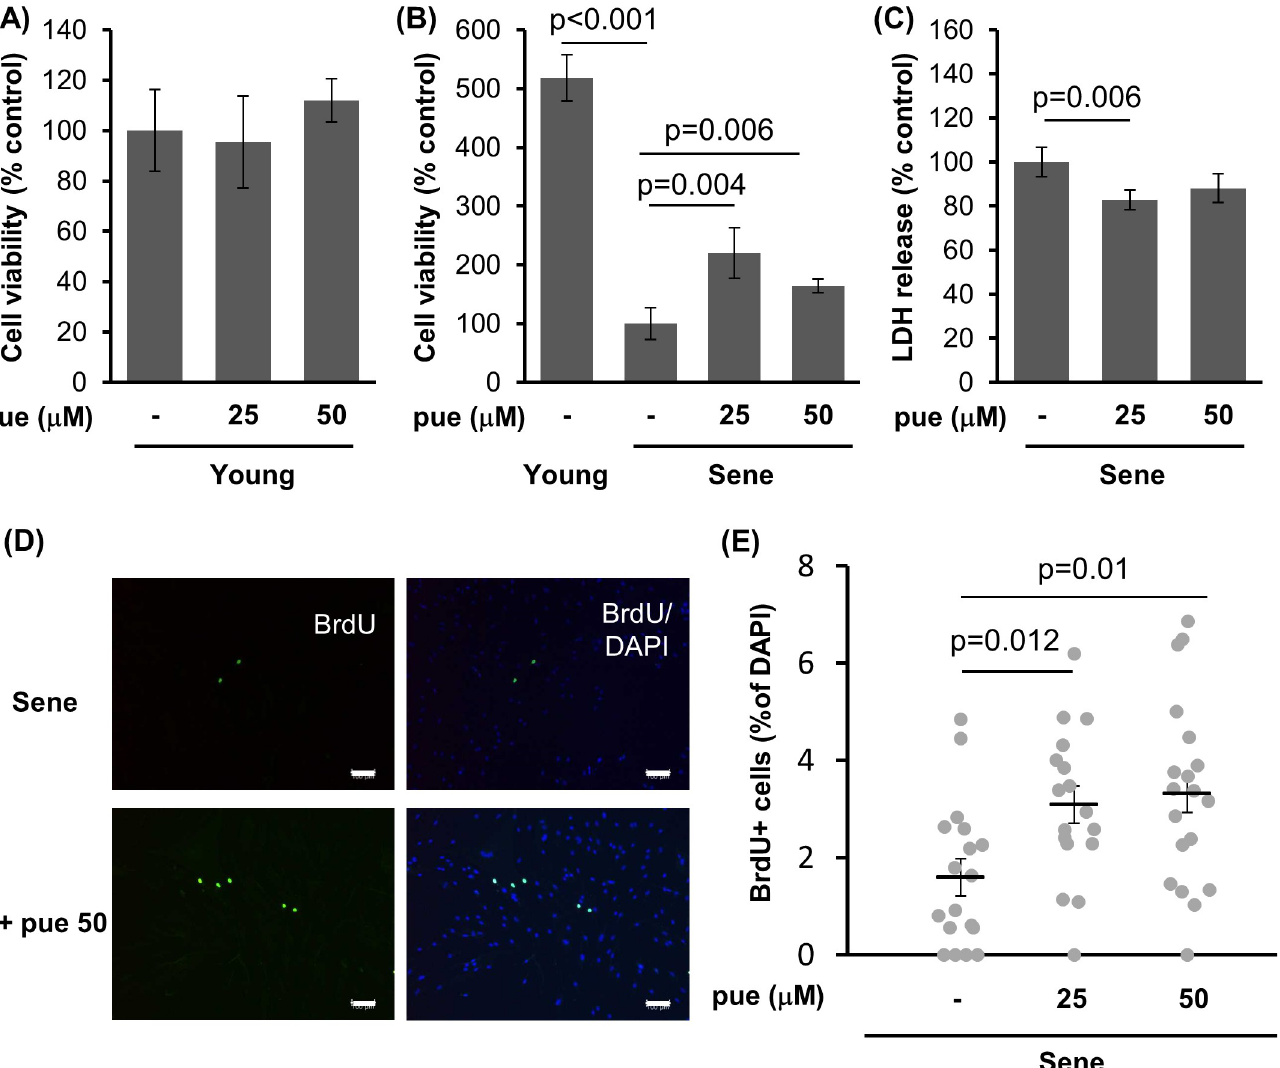
Fig 1. The effect of puerarin on the viability, injury and proliferative activity in high-passage NHDFs. A, B: The effect of puerarin (pue) on cell viability of young (A) and senescent NHDFs (B) was analyzed by CCK-8 assay. n = 5. C: The effect of cellular LDH release in high passage NHDFs. Data was obtained from LDH assay. n = 6. D, E: The effect of puerarin on the cell proliferative activity in senescent NHDFs. Cells were stained for BrdU and nuclei by specific antibody and DAPI, respectively, and photographed at 100 × magnification (D). The percentage of BrdU positive cells per total cells was calculated from 15 microscopic fields for each group. (E). Scale bars = 100 μ